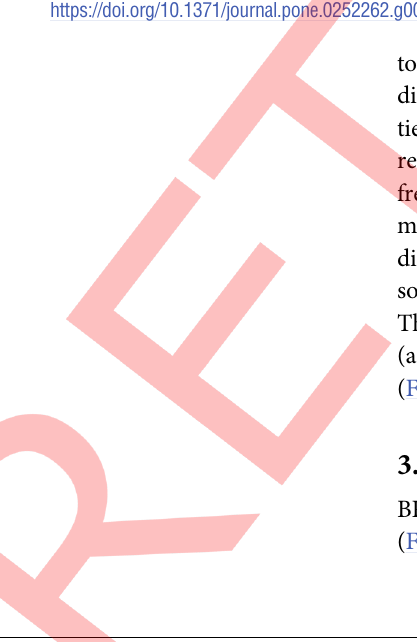
Fig 1. Rohlf PCA biplot of individuals and